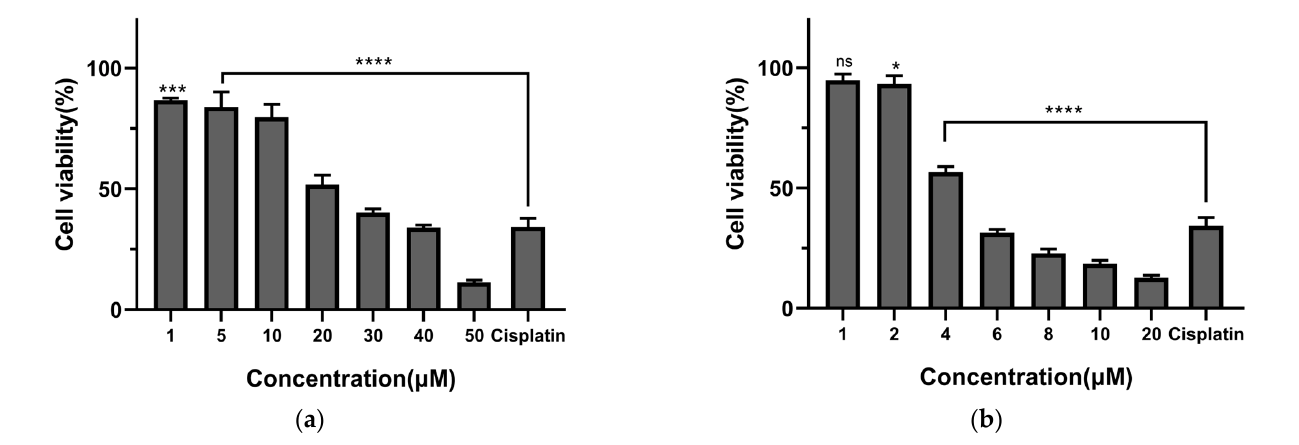
Figure 7. Cytotoxic effects of two compounds for 72 h on SW480 human colon cancer cells as measured using a cell viability assay. Cisplatin (5 µ M) was used as positive control. Asterisks indicate statistical significance at p < 0.05 and ns means no significant differences, compared to the untreated control group. ( a ) SW480 exposed to different concentrations of 1 . ( b ) SW480 exposed to different concentrations of 2 . The data are expressed as the means ± SD of four independent experiments.